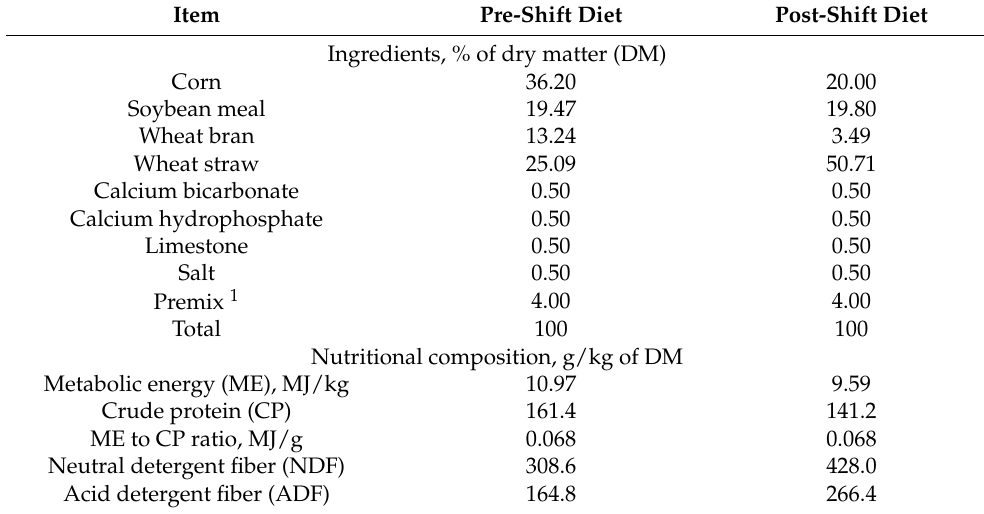
Table 1. Ingredients and nutritional composition of pre- and post-shift